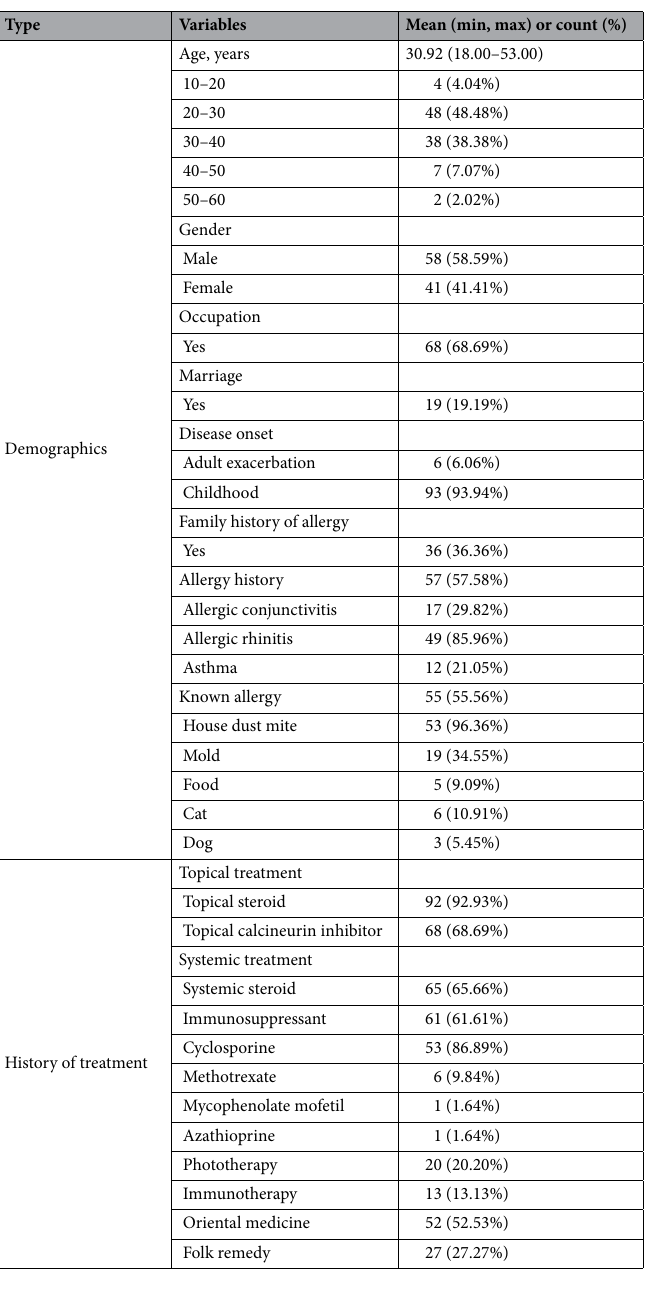
Table 1. Baseline demographics and history of treatment (n =